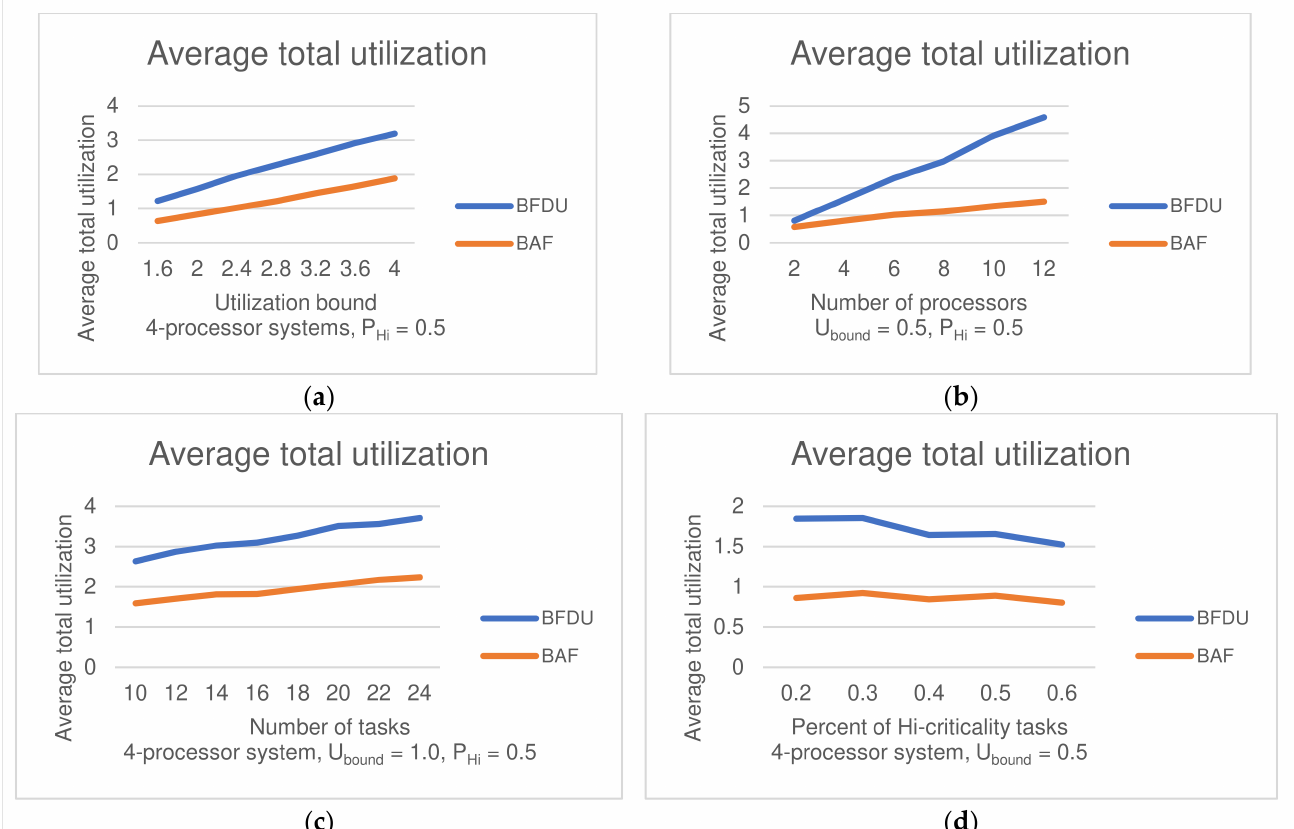
Figure 3. Average total processor utilization by varying: ( a ). the utilization bound, ( b ). the number of processors, ( c ). the number of tasks, ( d ). the percent of Hi-criticality tasks. U L = 0.05, U U = 0.75, Z L = 1, Z U =